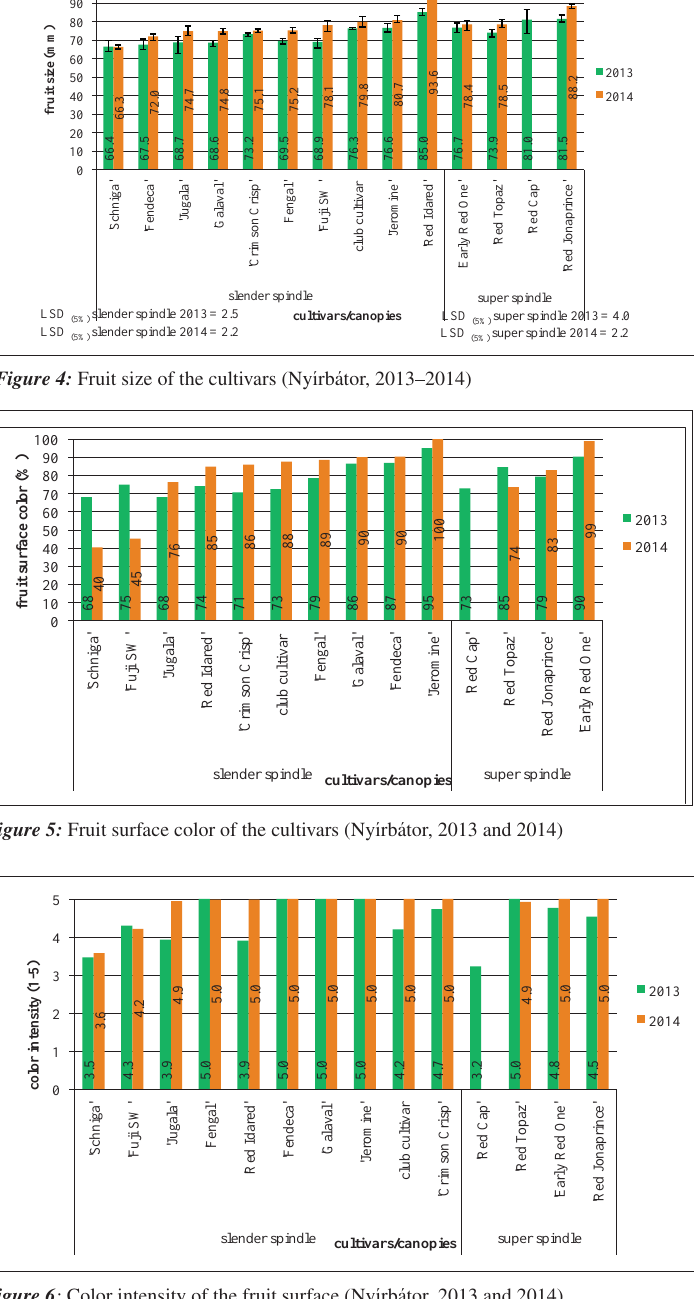
Figure 6 : Color intensity of the fruit surface (Nyírbátor, 2013 and